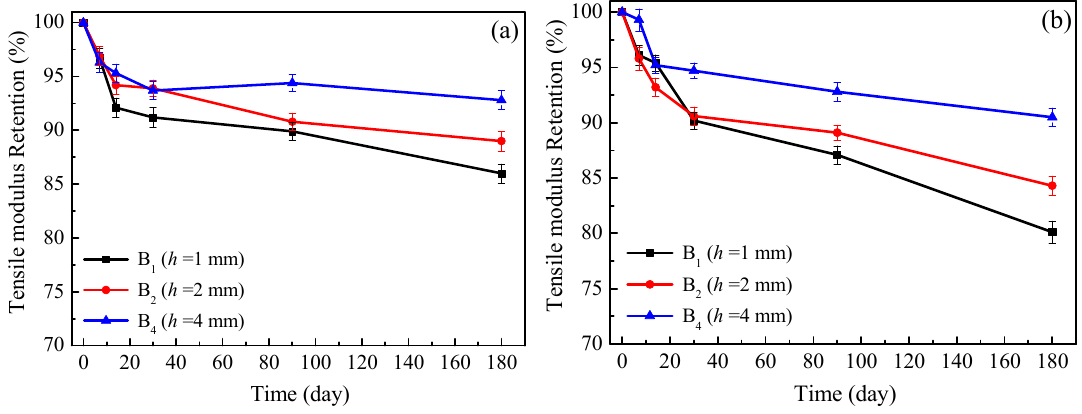
Figure 7. Variations of elastic modulus retention of BFRP laminates vs. ageing time soaked in ( a ) deionized water and ( b ) alkaline solution at 60 °C.